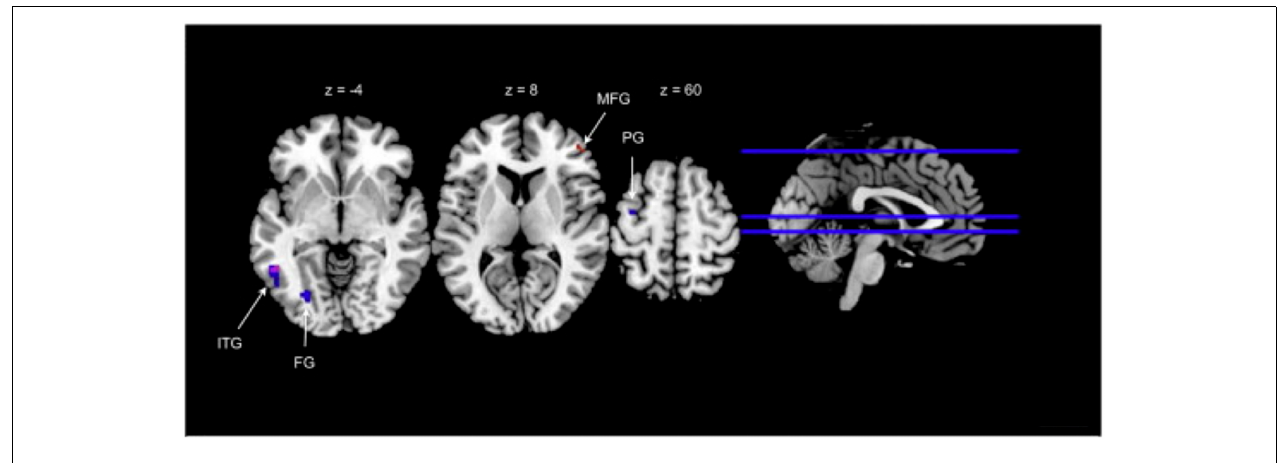
FIGURE 3 | Neural differences between those trained in an auditory attention task and controls as measured by fMRI. Brain regions displaying significant decreases at points during a selective auditory attention task amongst trained participants (taken and adapted from Bless et al.,